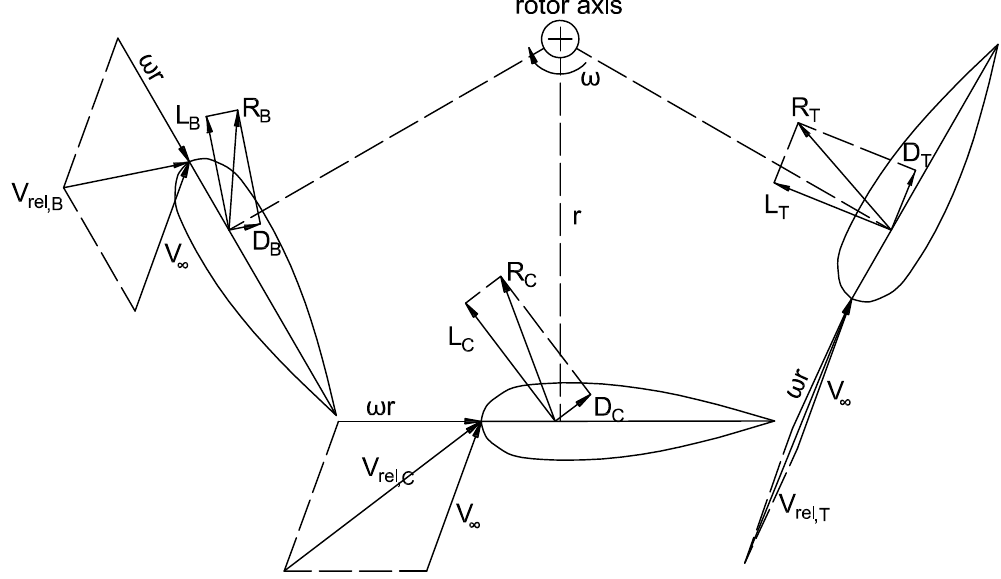
Figure 4. Scheme of central (C), top (T) and bottom (B) sections of an helix blade. As the angle of attack (AoA) changes, lift (L) and drag (D) in different sections are